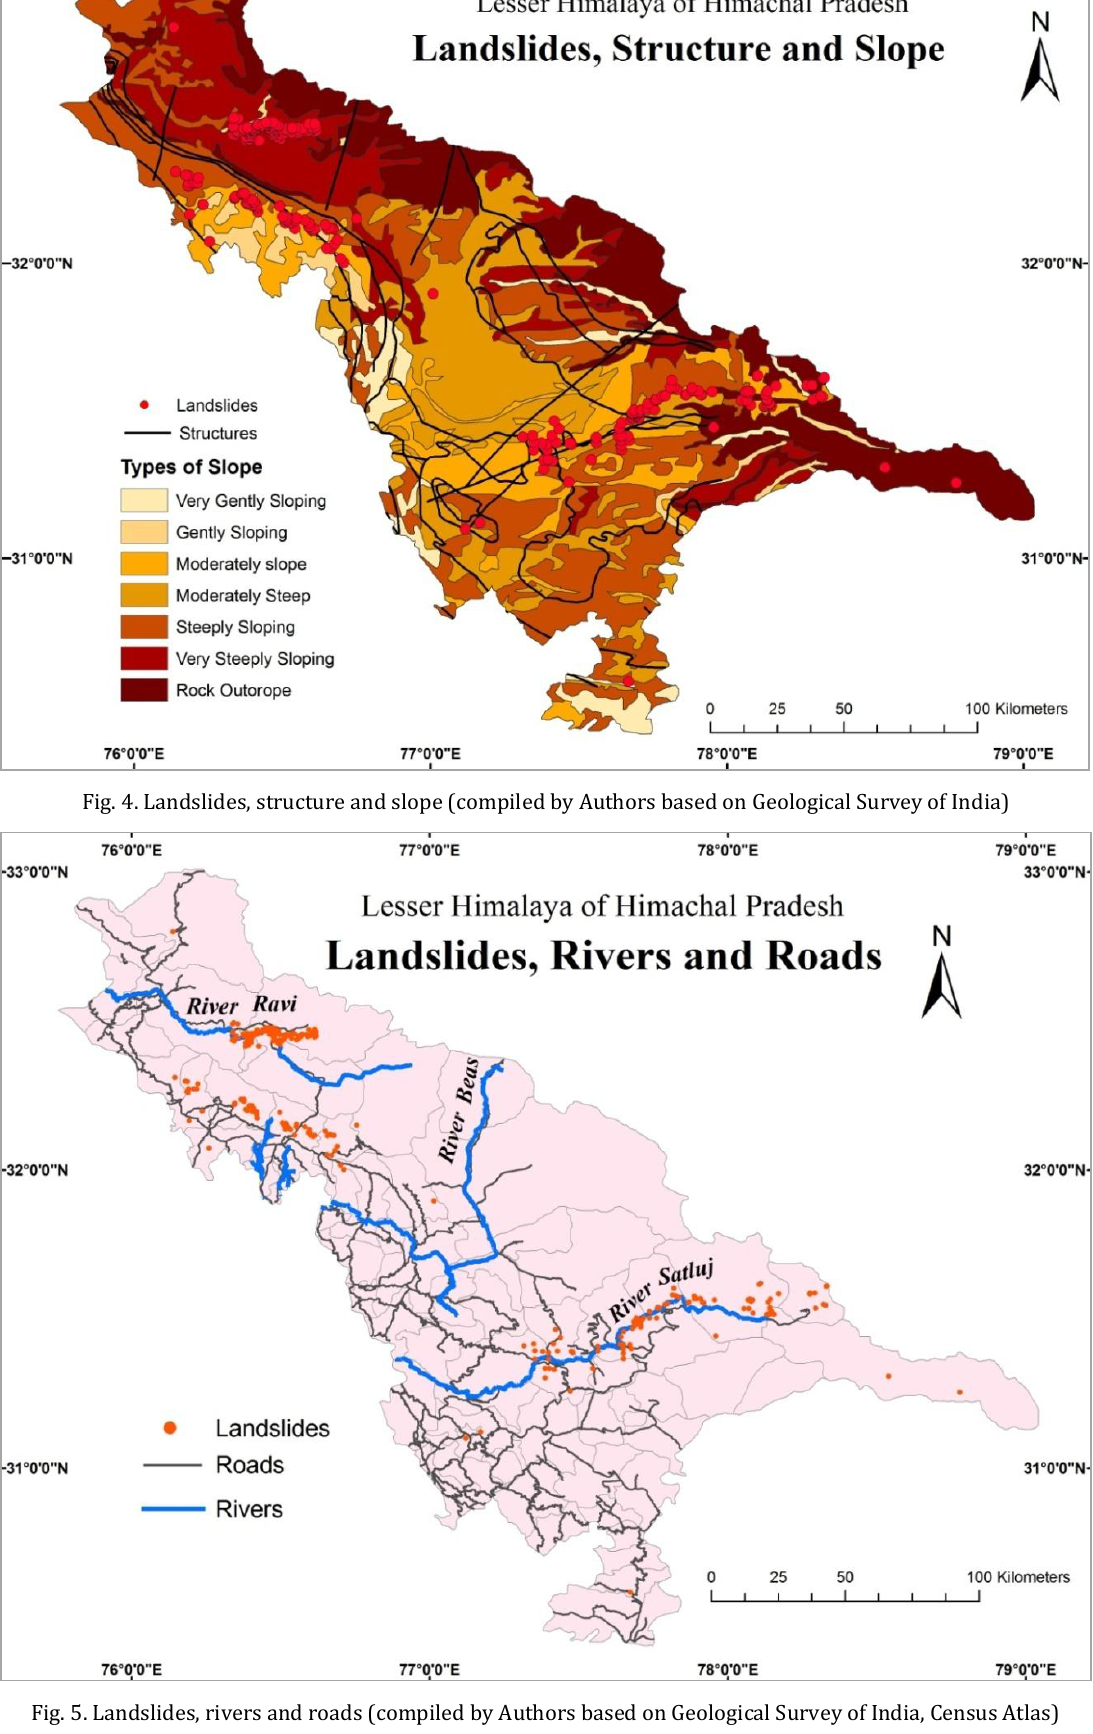
Fig. 5. Landslides, rivers and roads (compiled by Authors based on Geological Survey of India, Census